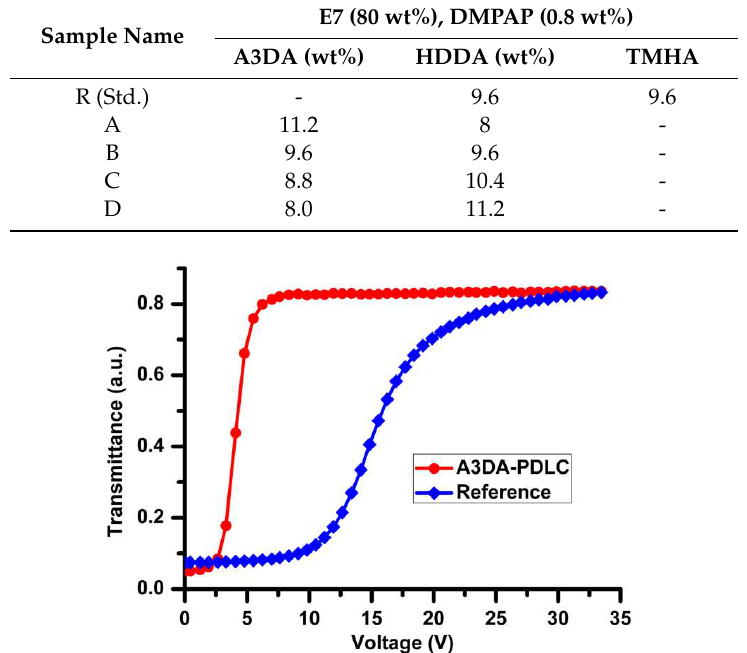
Table 1. Chemical compositions of the PDLC precursors.